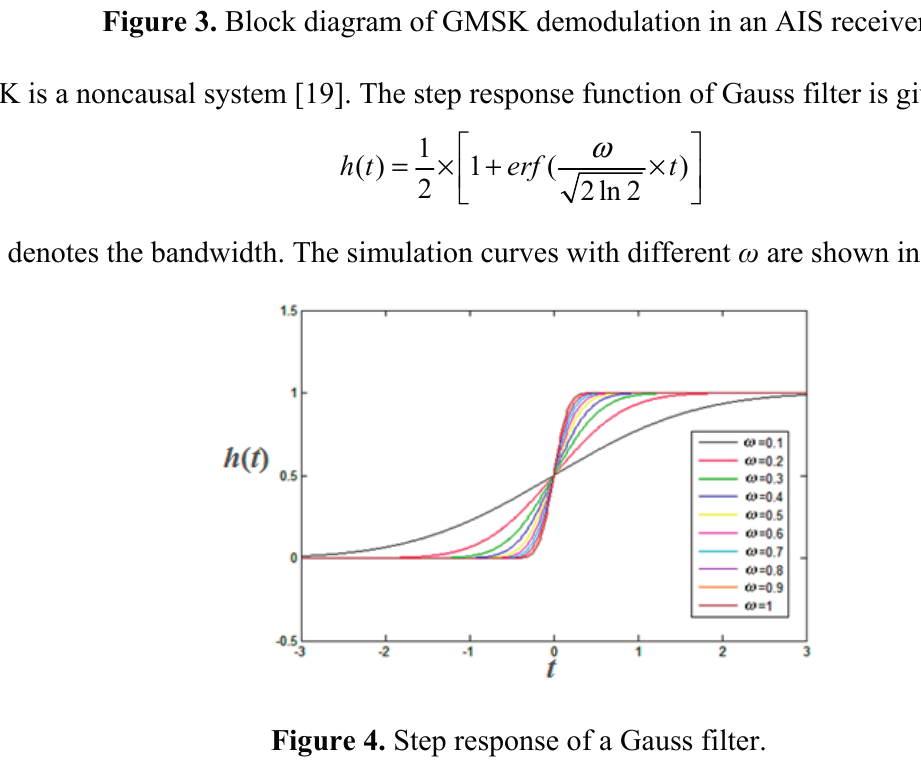
Figure 4. Step response of a Gauss